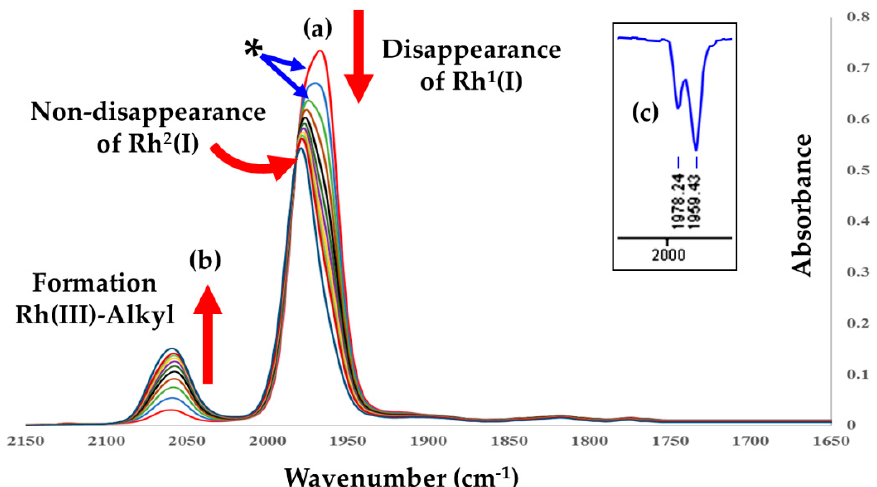
Figure 4. Successive infrared spectra illustrating the oxidative addition of iodomethane to [Rh 1 (Indol’)(CO)(PPh 3 )Rh 2 (CO)(PPh 3 ) 2 ] ( B2 ), showing ( a ) the disappearance of the signal at ν (CO) = 1967 cm − 1 (representing the ‘sum’ of the two Rh fragments, Rh 1 (I) and Rh 2 (I); also note the shoulder at the asterisk as indicated) and ( b ) the simultaneous definition of (i) the Vaska fragment at 1980 cm − 1 and (ii) the appearance of the Rh(III)-alkyl species at ( ν (CO) = 2060 cm − 1 ), in dichloromethane at 25 °C. [ B2 ] = 0.0058 M, [MeI] = 0.064 M, and Δ t = 120 s; Total time = 20 min. Insert ( c ) illustrates the similar wavenumber range in the solid state IR ATR spectrum, and the two ν (CO) peaks associated with Rh 1 (I) and Rh 2 (I) are more clearly defined at ν = 1959 and 1978 cm − 1 , respectively (see also Figure S4 in Supplementary Materials).